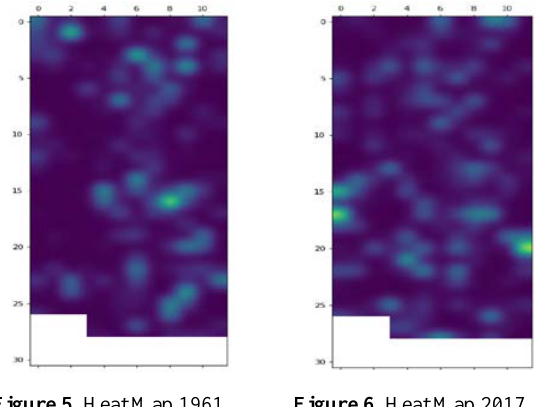
Figure 10. Weather Station Data PAGASA-DOST